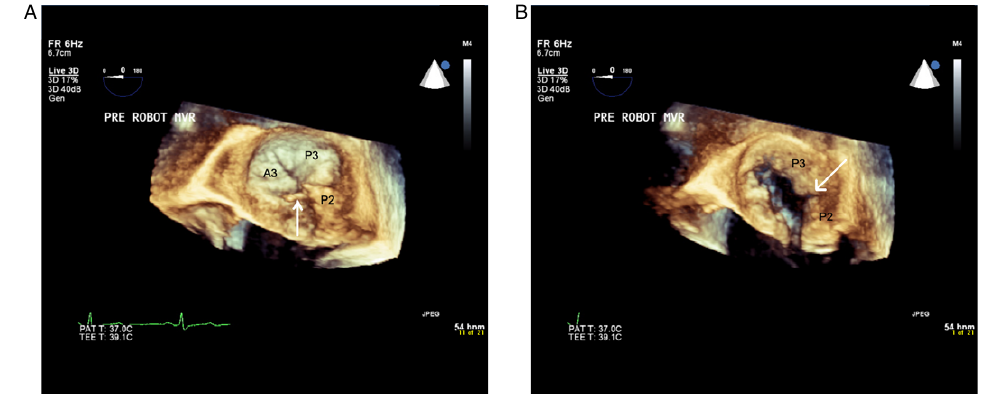
Figure. 5 Real-time 3D echocardiograph image obtained by cropping from the lateral wall (A) shows flail P2 with ruptured chord (arrow) and (B) shows cleft between P2 and